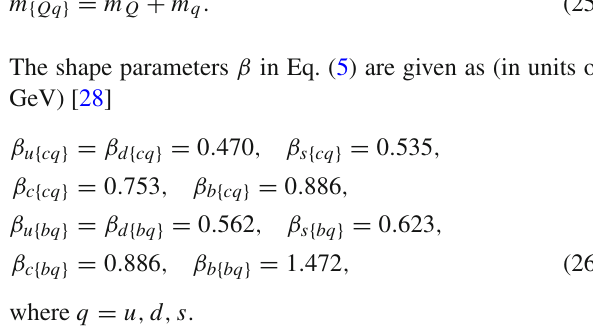
Table 3 Flavor–spin overlap factors for the bc sector. B ( 1 , 2 )